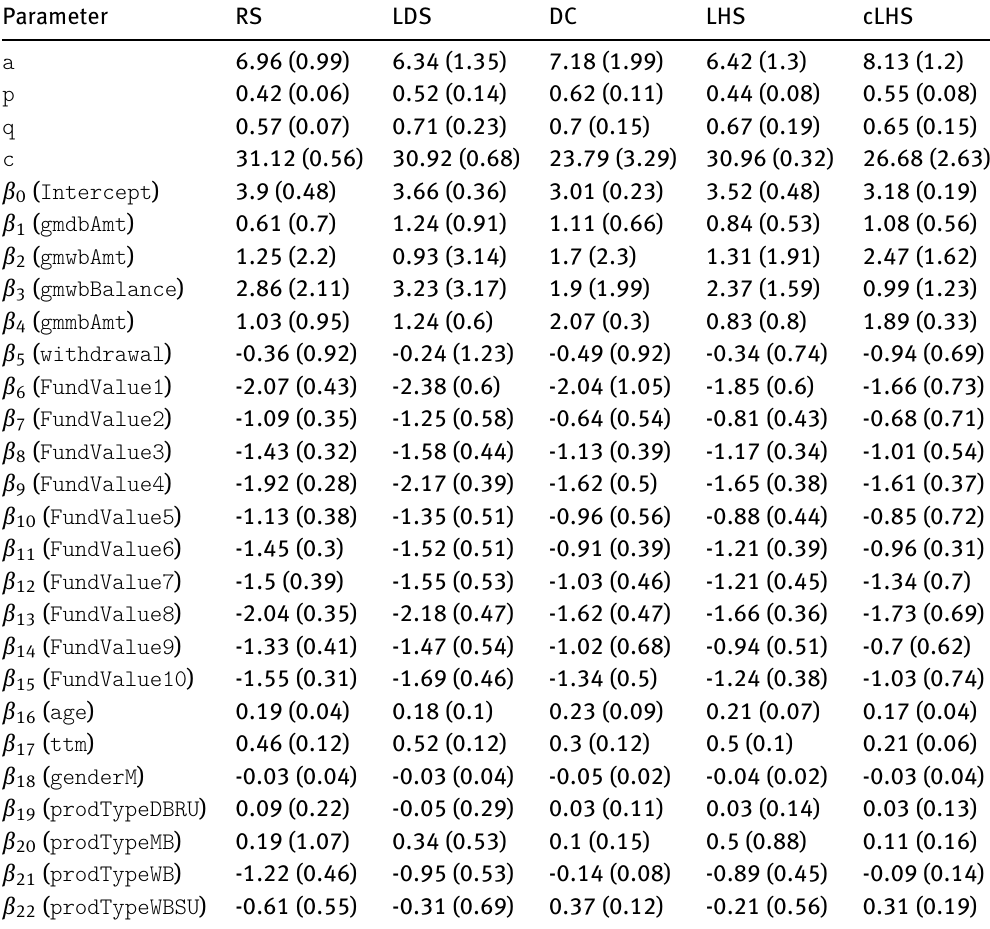
Table 6: The average and standard deviation of the estimated parameters of the GB2 model over 10 runs when s = 440 . Parameter RS